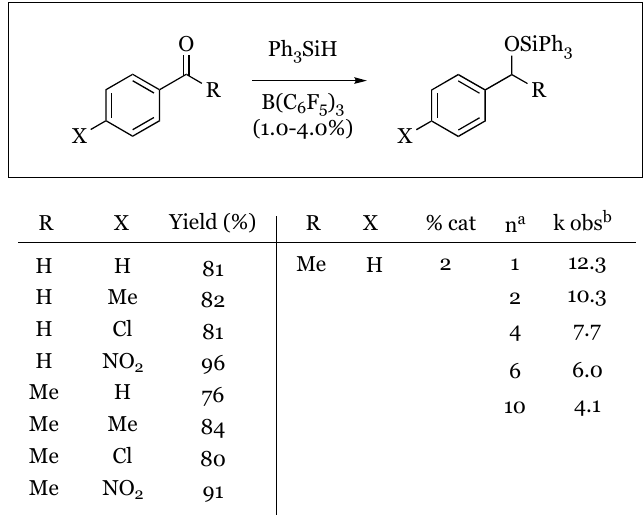
Figure 34. Hammett study of aromatic aldehydes and ketones. a For n = 1, concentration = 0.385 M; b First-order rate constants.